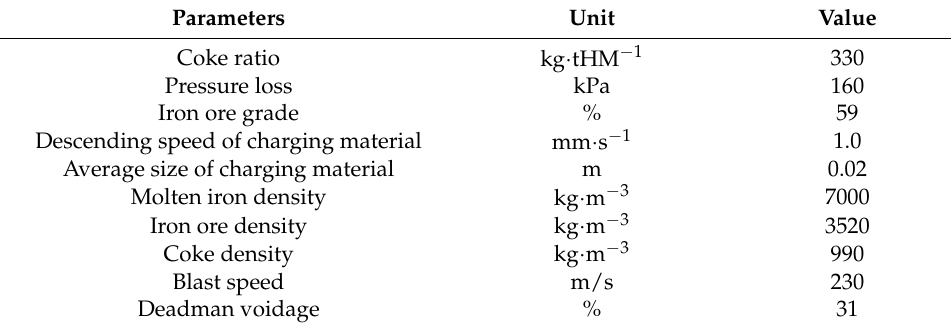
Table 2. Main operating parameters of WISCO No. 1